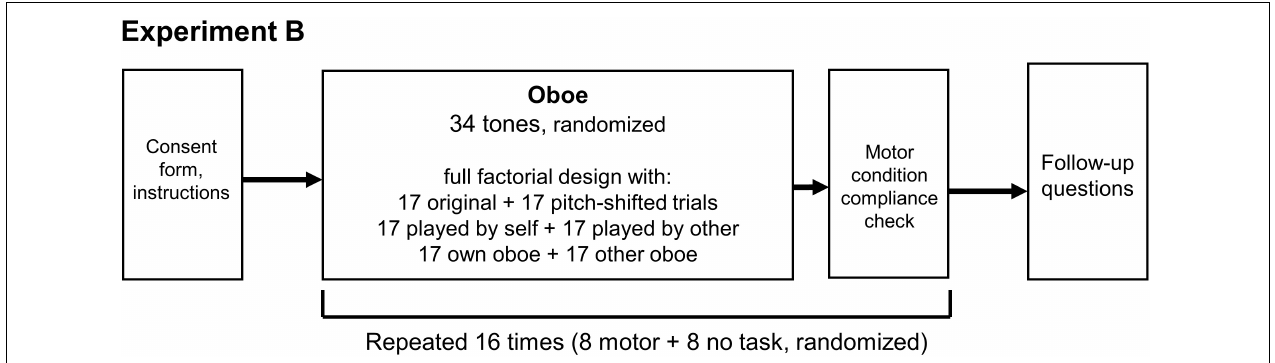
FIGURE 4 | Experimental design for Experiment B, consisting of 16 blocks of 34 randomized tones each. Within each of the blocks, three of the conditions were balanced (self vs. other, own instrument vs. other, and pitch-shifted vs. original). Participants engaged in the motor tasks during 8 of the 16 blocks; the presentation order of motor vs. no motor blocks was randomized. For further detail on the distribution of trials within blocks see Supplementary Table 1 .